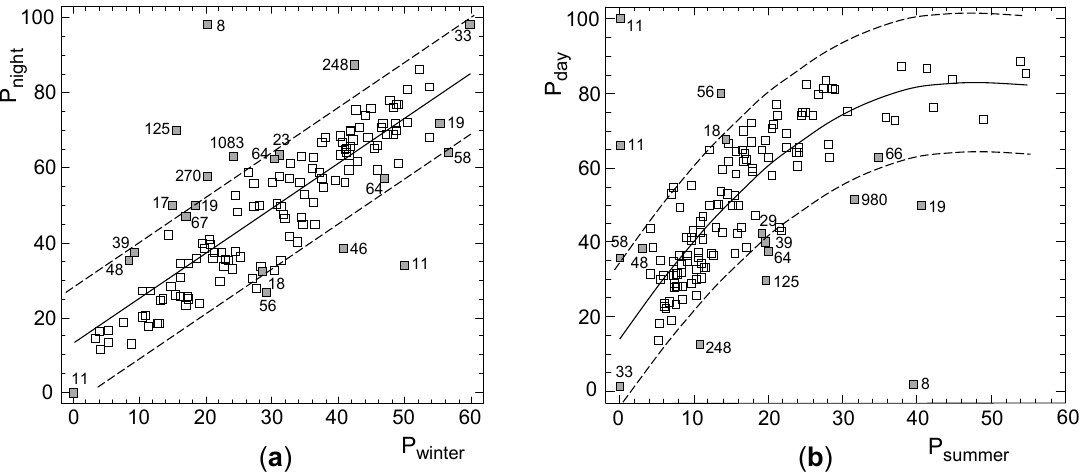
Figure 1. Consumer preferences about 140 perfumes (data from [8]). ( a ) Percentage of subjects who considered the fragrance more suitable for nighttime wear ( P night ) versus for the winter season ( P winter ); ( b ) preference for daytime wear ( P day ) versus preference for summertime ( P summer ). Values next to each observation indicate the number of subjects who voted to provide this information. Dashed lines: prediction limits (confidence level: 95%) calculated after discarding 8 outlying observations.